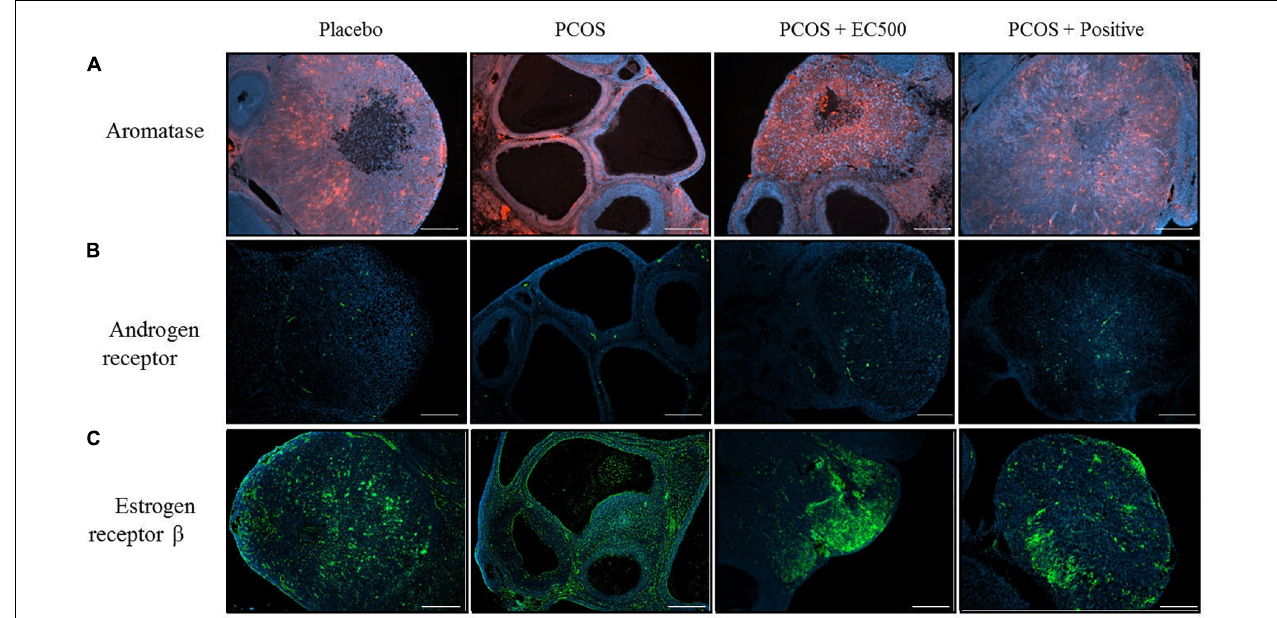
FIGURE 7 | Effect of E. cava treatment on aromatase, androgen receptor, and estrogen receptor β localization. For PCOS experiments, 6-week-old female rats were administered letrozole pellets (0.1 mg/kg/day). After 2 weeks, E. cava extract was administered via P.O. treatment every day for 2 weeks. Immunohistochemistry was performed on ovarian sections using specific (A) aromatase (CYP19A1), (B) androgen receptor antibodies, and (C) estrogen receptor β antibodies. The secondary antibody was donkey and rabbit (scale bar = 200 µ m). Magnification, 40 × . EC, E. cava extract; PCOS, polycystic ovary syndrome.